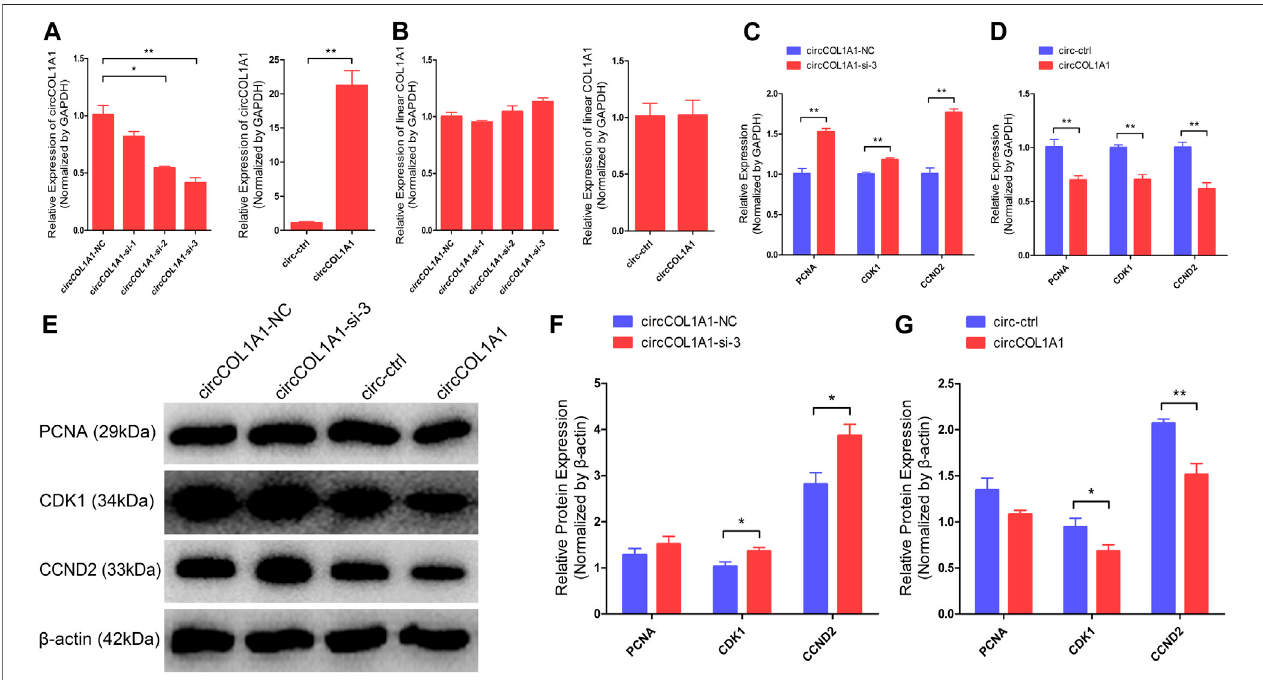
FIGURE3| CircCOL1A1negatively regulatesgoathair folliclestemcell proliferation. (A) CircCOL1A1wassuccessfullysuppressed oroverexpressed inhairfollicle stemcells aftertransfection withthecircCOL1A1-siRNAsand overexpressionplasmidfor48 h. (B) LinearCOL1A1mRNAwasnotsuppressed oroverexpressed inhair follicle stem cells after transfection with the circCOL1A1-siRNAs and overexpression plasmid for 48 h (C,D) Relative mRNA expression of PCNA, CDK1, and CCND2 at 48 h after transfection with circCOL1A1-si-3 (C) and circCOL1A1-overexpressing plasmid (D) . (E,F,G) Protein expression of PCNA, CDK1, and CCND2 at 48 h aftertransfectionwithcircCOL1A1-si-3andcircCOL1A1-overexpressingplasmids. (H) RepresentativeimagesoftheEdUassayat48 haftertransfection.Bars,200 µm. (I,J,K,L) The cell cycle distribution was detected at 48 h after transfection by fl ow cytometry (I,J) , and the distribution was determined (K,L) .